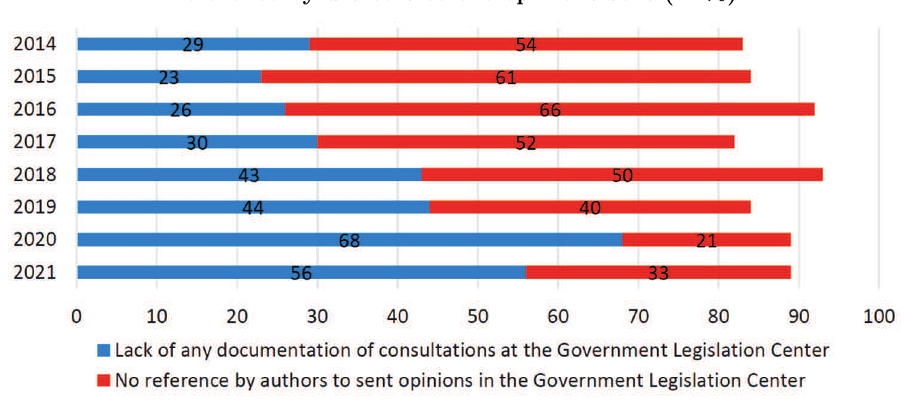
Percentage of draft laws submitted in Poland for which there is no documented public consultation and for which there is no reference by drafters to the opinions sent (in